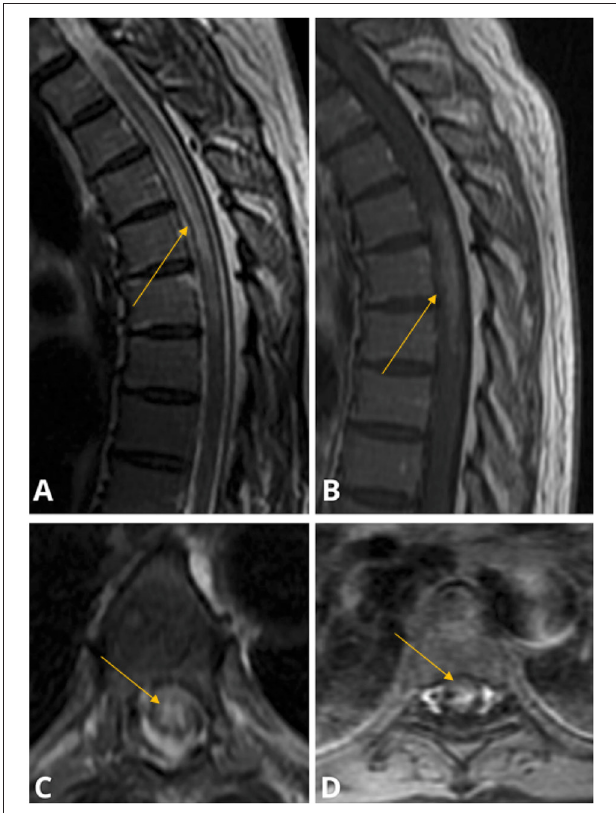
FIGURE 5 | Case 3: Sagittal (A) and Axial (C) MRI T2 STIR demonstrating central gray-matter predominant hyperintensity spanning the T2–T9 vertebrae; Sagittal (B) and Axial (D) MRI T1 with gadolinium study demonstrating centrally enhancement spanning T5–T7 levels. The brain, cervical and lumbar cord were spared and thus not